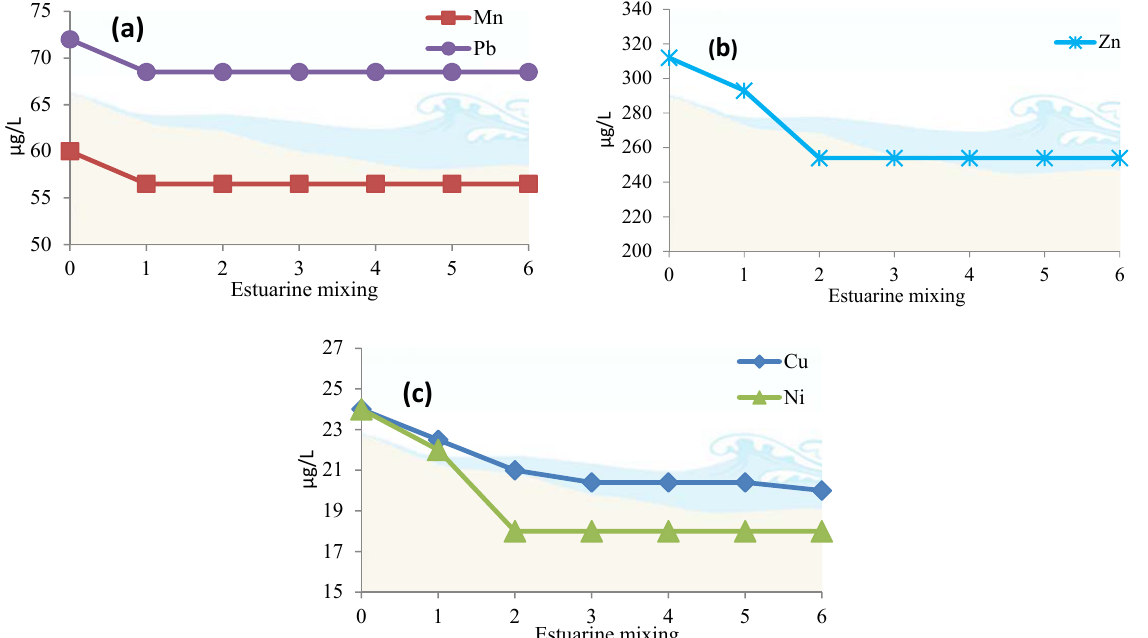
Fig. 4: Reduction trend of concentration of Pb and Mn (a), Zn (b), Cu and Ni (c) due to flocculation process in Sardabroud’s estuary